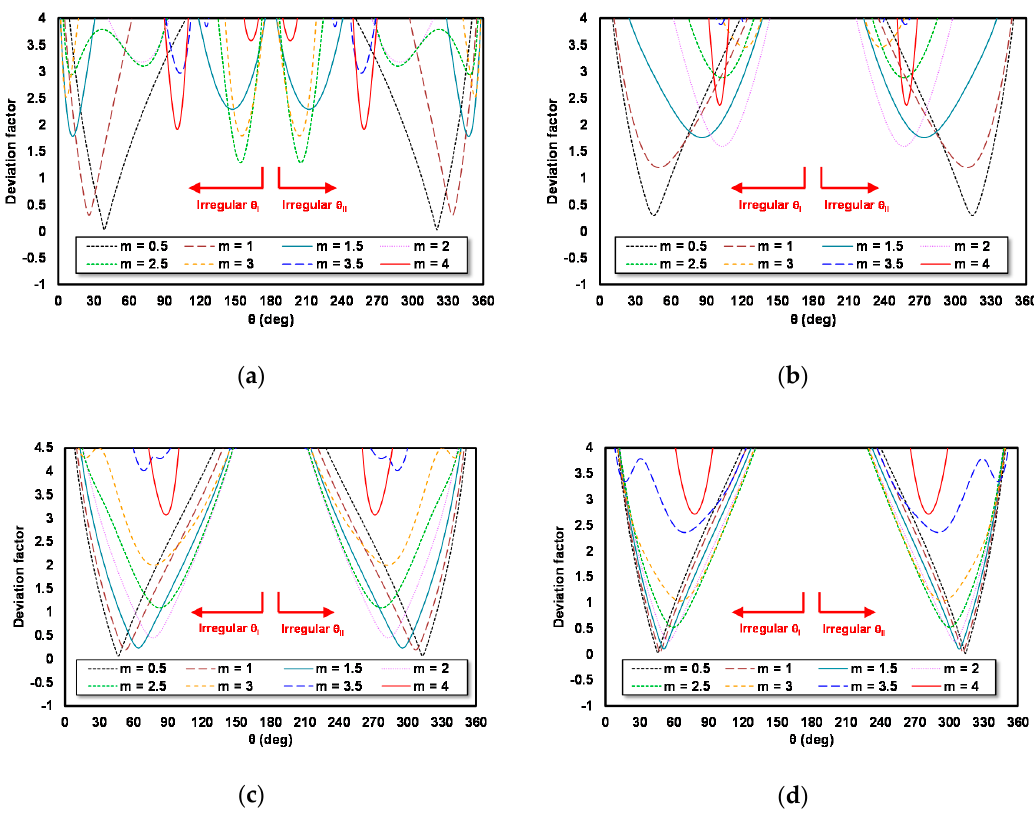
Figure 9. Deviation factor as the θ function for ( a ) scheme C1; ( b ) C2; ( c ) C3; and ( d ) C4.